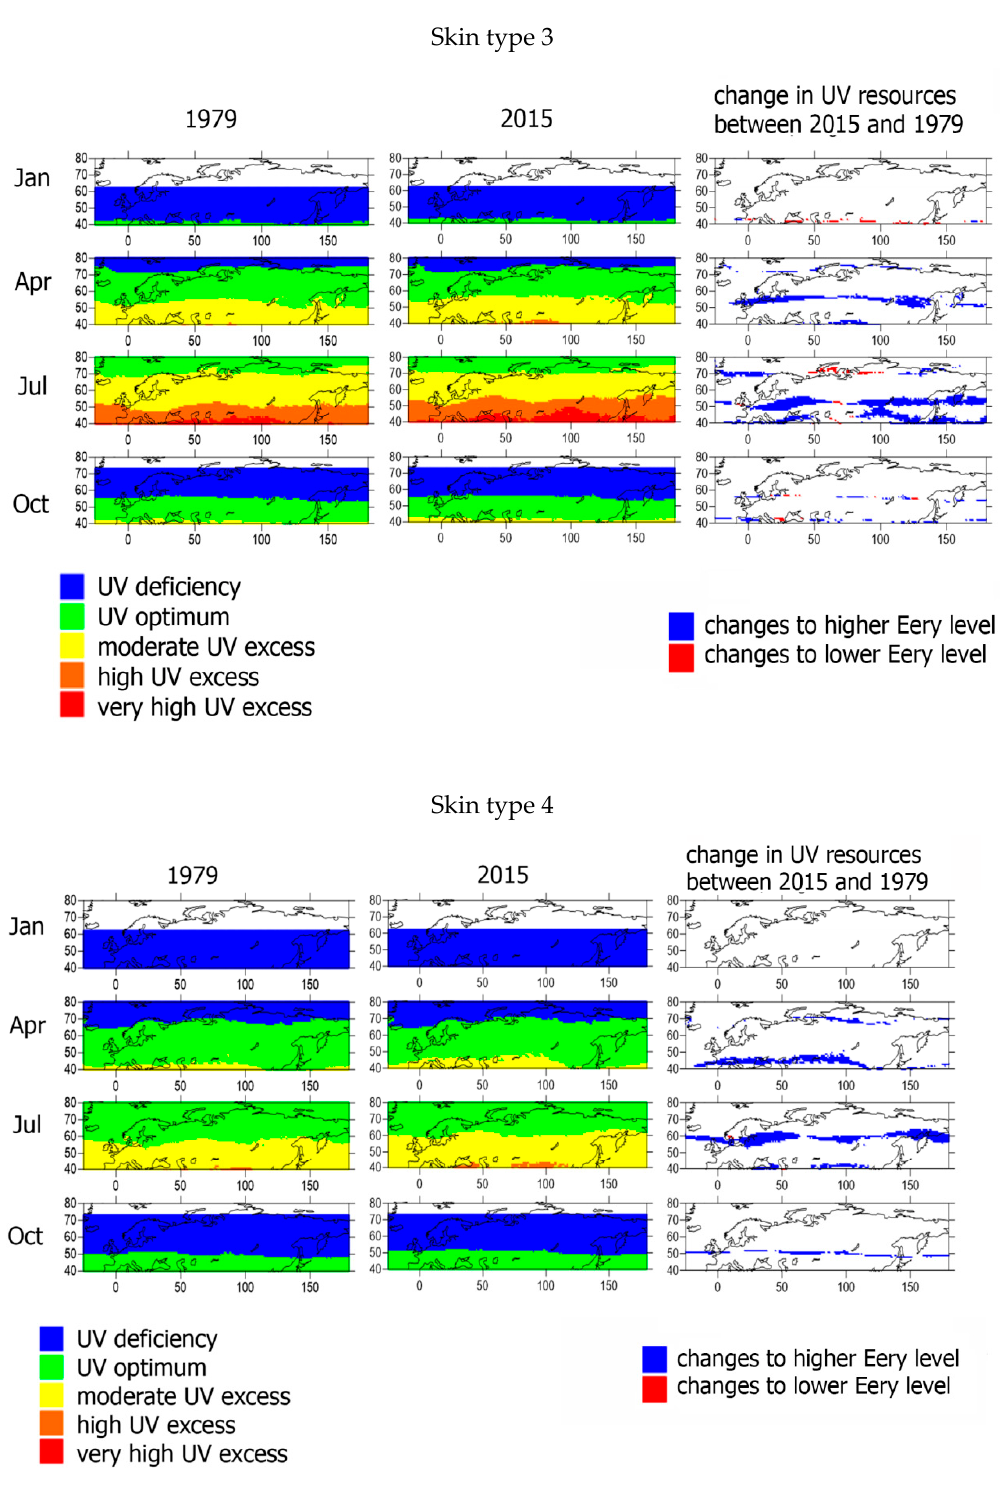
Figure 14. UV resources for 1979 and 2015 and changes in their distribution between 2005 and 1979 according to the retrievals from the ERA-Interim data for different skin types. X-axis—is longitude, Y-axis—is latitude.